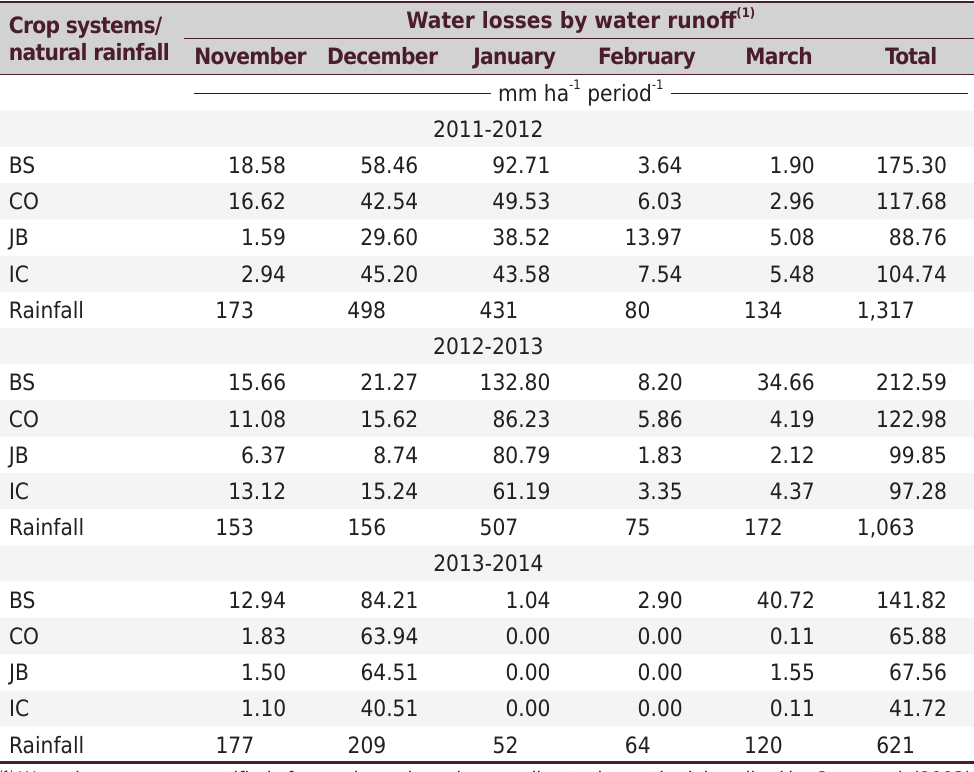
Table 5. Water losses by water runoff in different crop systems and natural rainfall in three crop systems, for each month and for the total period, from November to March of 2011 to 2012, 2012 to 2013, and 2013 to 2014, in Lavras, MG, Brazil Crop